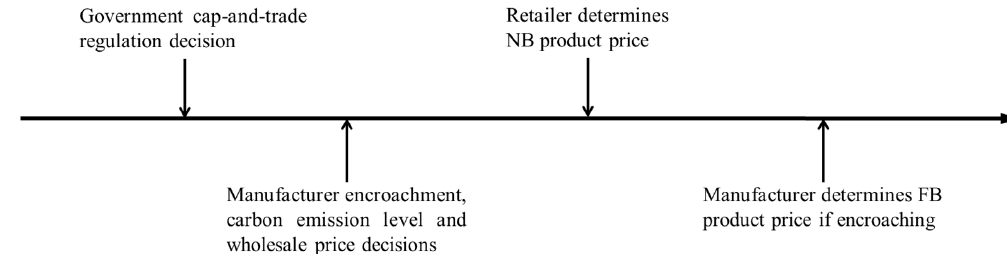
Figure 2. Decision timeline for all members.